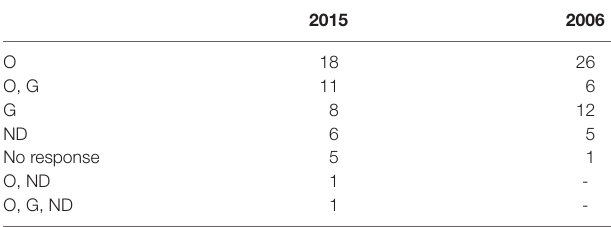
Table 2 | Comparison of the number of states utilizing specific reviewer types. Table 1 | Comparison of the number of states using an index to determine